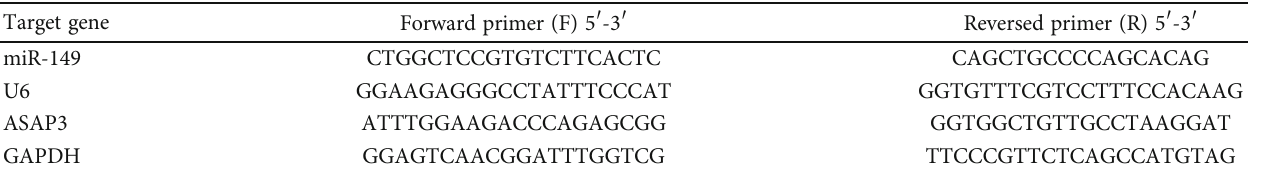
Table 1: Primer sequences of RT-qPCR.